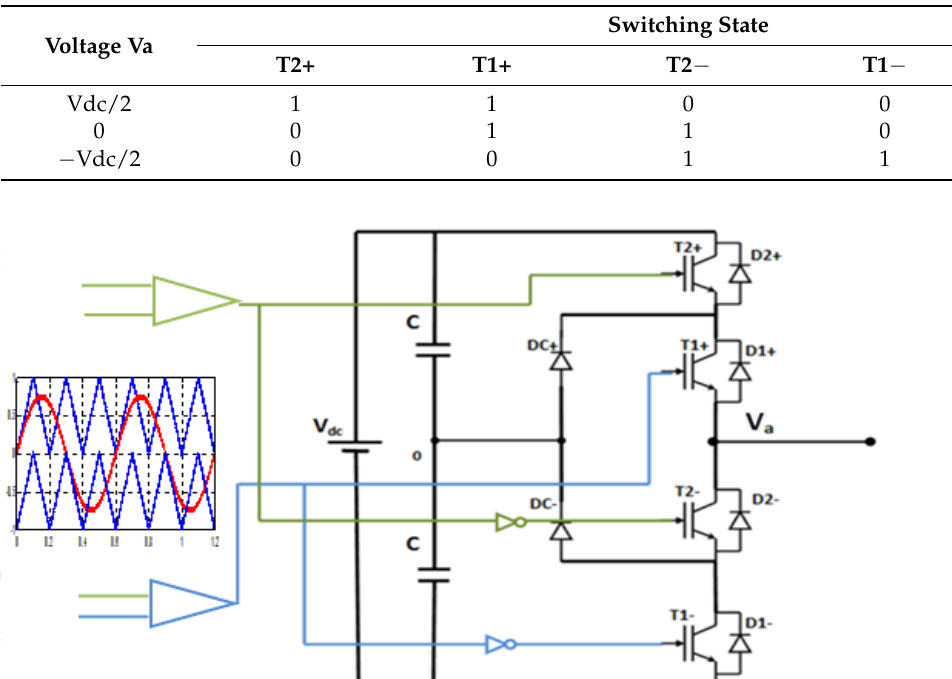
Figure 6. Structure of the SPWM for 3L_NPC inverter.